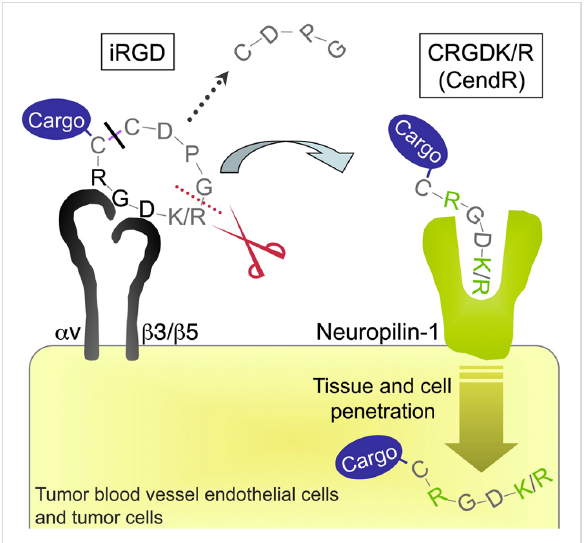
Figure 3: Binding and penetration mechanism of iRGD. The iRGD peptide is accumulated on the surface of α v integrin-expressing endo- thelial and other cells in malignancies. The RGD motif is responsible for binding to integrins. Afterward, the peptide is cleaved by cell sur- face-associated protease(s) to eventually expose the cryptic CendR el- ement, RXXK/R, at the C-terminus (red dotted line). The CendR ele- ment then interferes with the binding to neuropilin-1, resulting in tissue and cell penetration. The tumor-penetrating peptide can be used to decorate a cargo (a simple chemical moiety or a nanoparticle), but only in the case that the cargo is attached to the N-terminus of the iRGD peptide as the disulfide bond is cleaved before the peptide is internal- ized (black line). The figure was adopted from reference [81] (© 2009 Elsevier